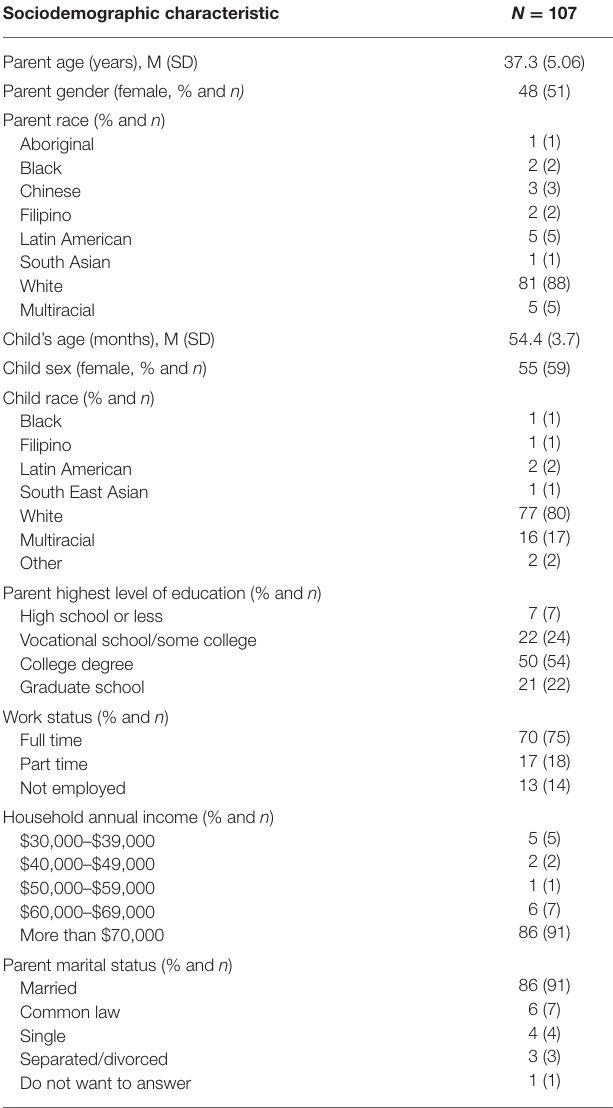
TABLE 1 | Sociodemographic characteristics of the